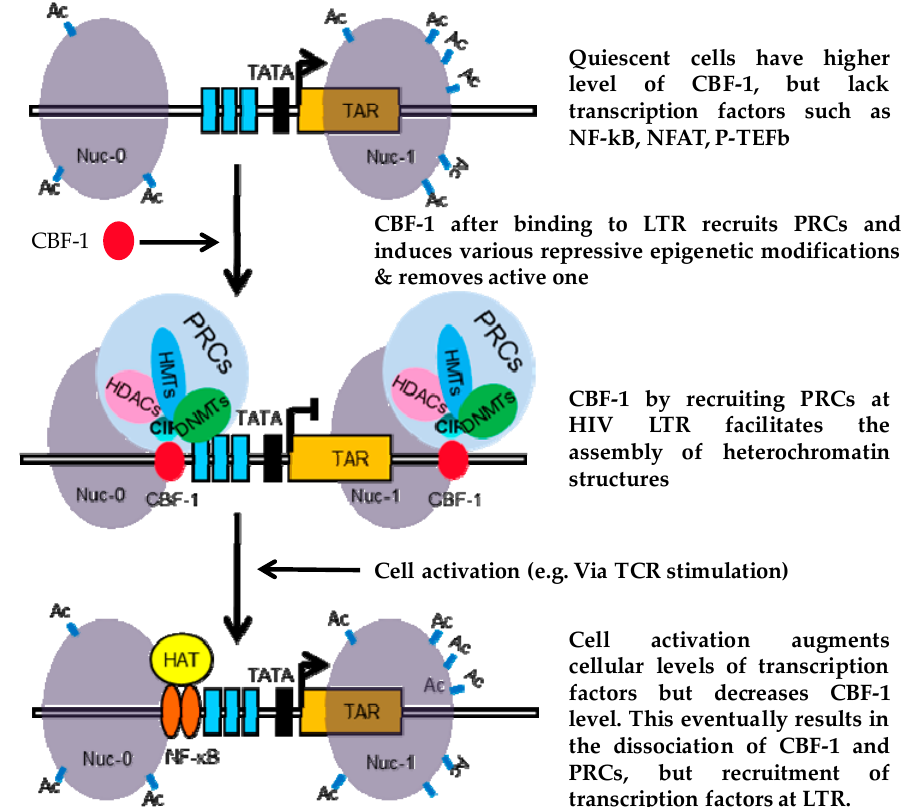
Figure 6. Model of CBF-1 functioning. Based on our findings, we propose the following model for the regulation of HIV latency by CBF-1. The higher levels of CBF-1 and lack of transcription factors such as NF-kB and NFAT in quiescent cells facilitates the binding of CBF-1 at HIV LTR. CBF-1 after binding to LTR recruits PRCs. PRCs subsequently promote heterochromatin environment at HIV LTR and inhibit the free flow of transcription machinery, thus facilitating the establishment and maintenance of HIV latency. Following cellular activation, the levels of CBF-1 drop, but the levels of NF-kB and NFAT rise in the nucleus, which displaces CBF-1 and corepressor complexes from their binding sites. Eventually, these factors recruit coactivator complexes at HIV LTR, which then